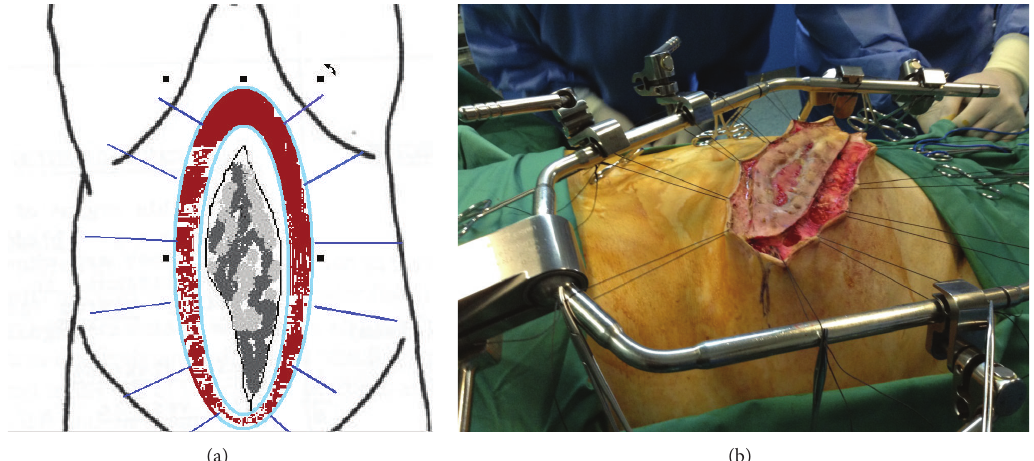
Figure 2: Edges of the surgical wound were lifted upwards and suspended under traction by threads from a frame positioned horizontally above the abdomen.